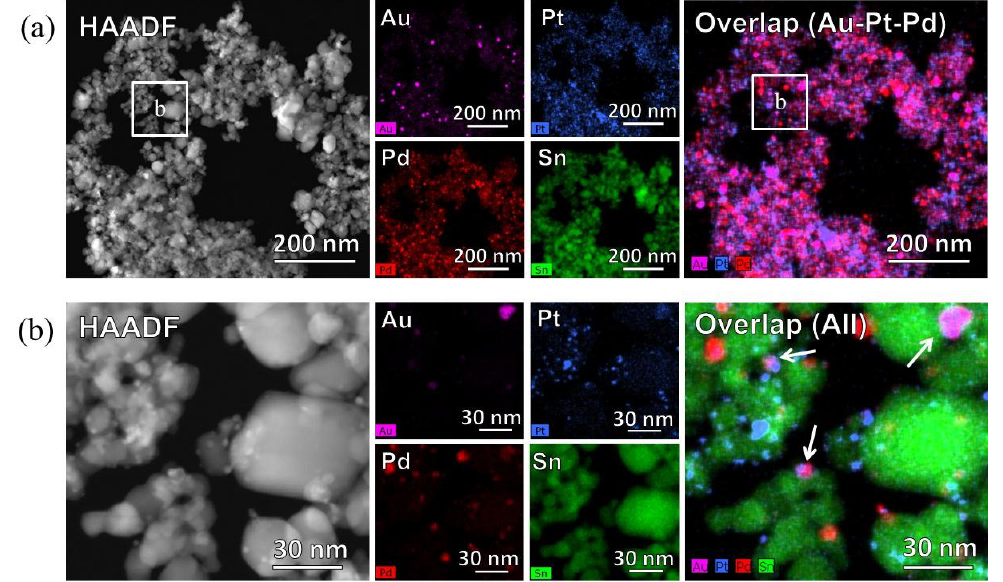
Figure 6. High-angle annular dark field scanning transmission electron microscopy (STEM-HAADF) and STEM-energy dispersive X-ray spectroscopy (STEM-EDS) images of the AuPtPd/SnO 2 catalyst